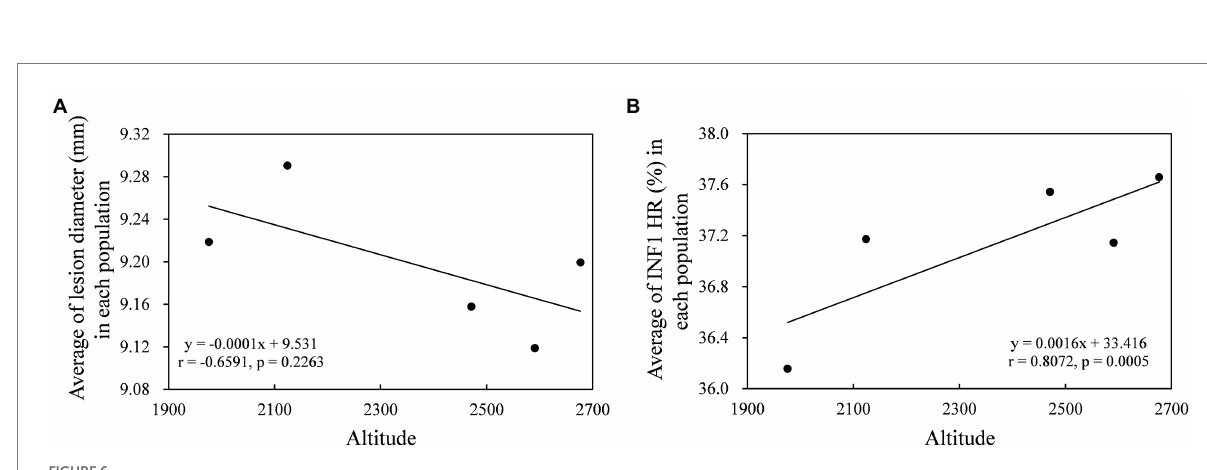
FIGURE 6 Correlation between the altitude of the collection sites and lesion size (A) and INF1 suppression (B) of pathogen